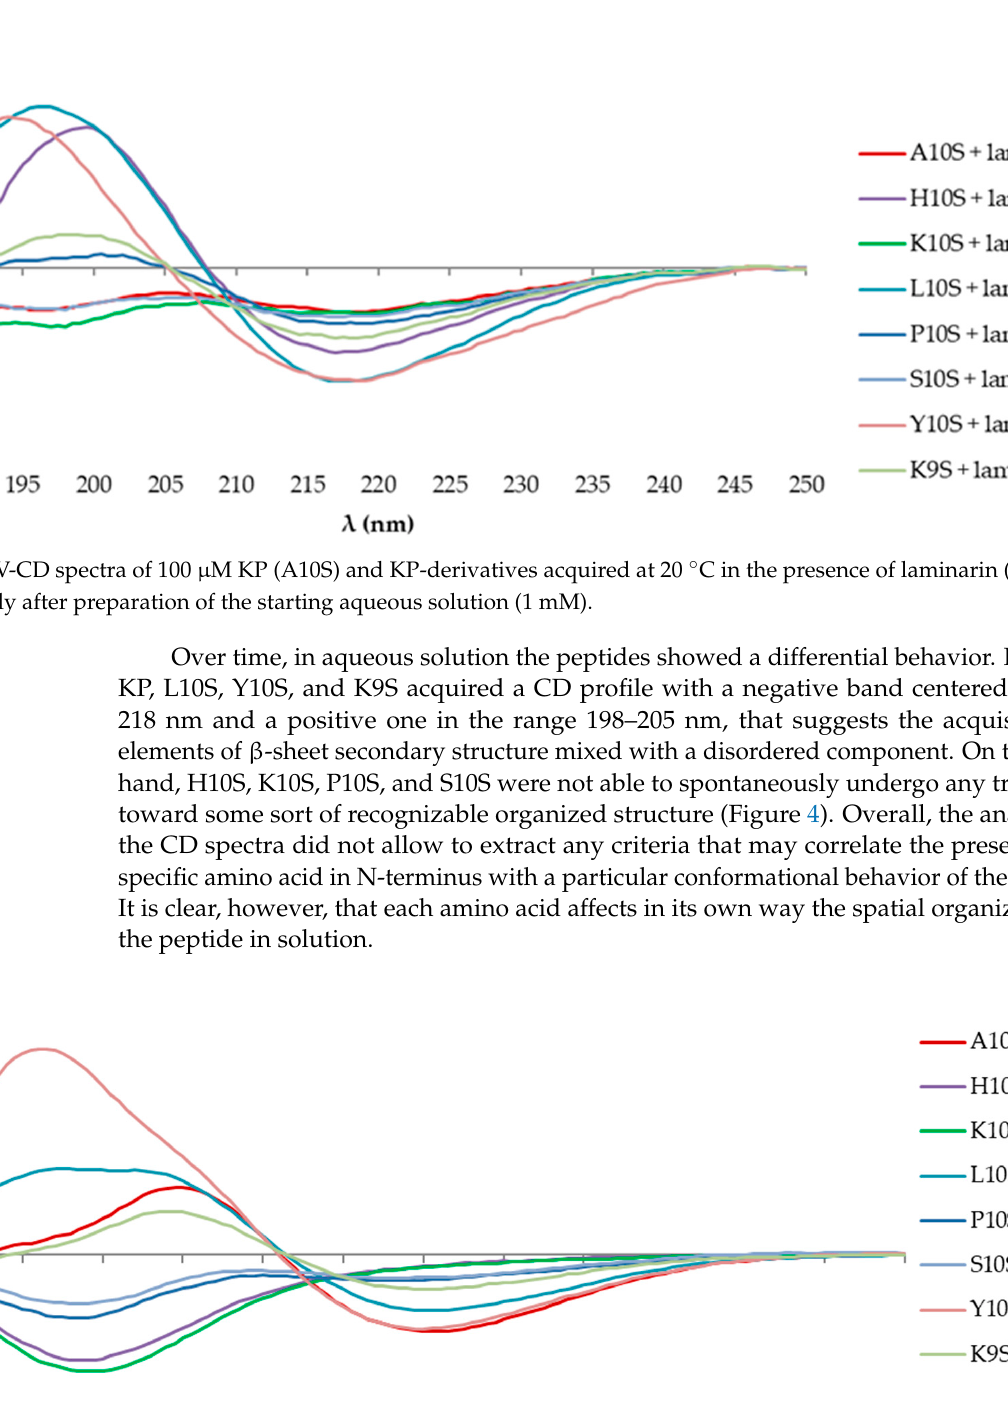
Figure 2. Far UV-CD spectra of 100 µM KP (A10S) and KP-derivatives acquired at 20 °C immediately after preparation of the starting aqueous solution (1 mM).